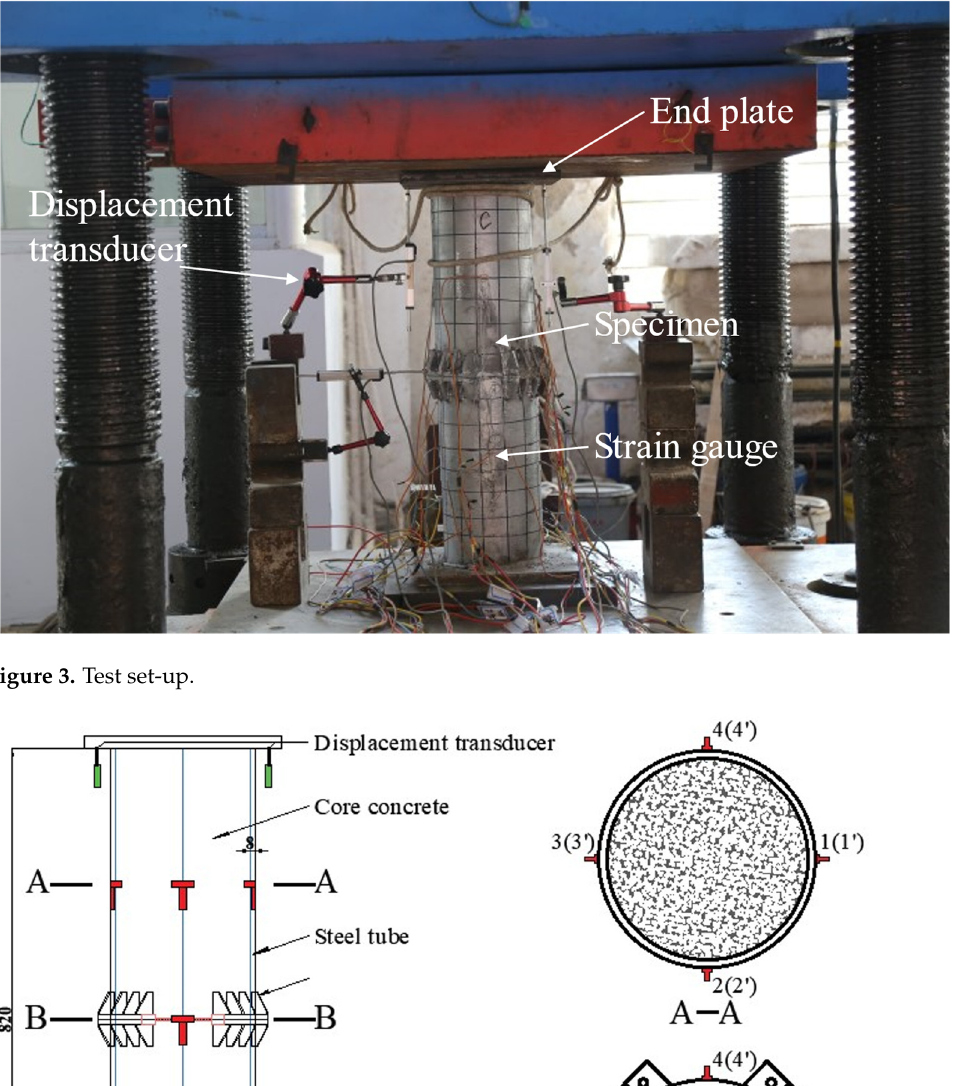
Figure 4. Measurement scheme.